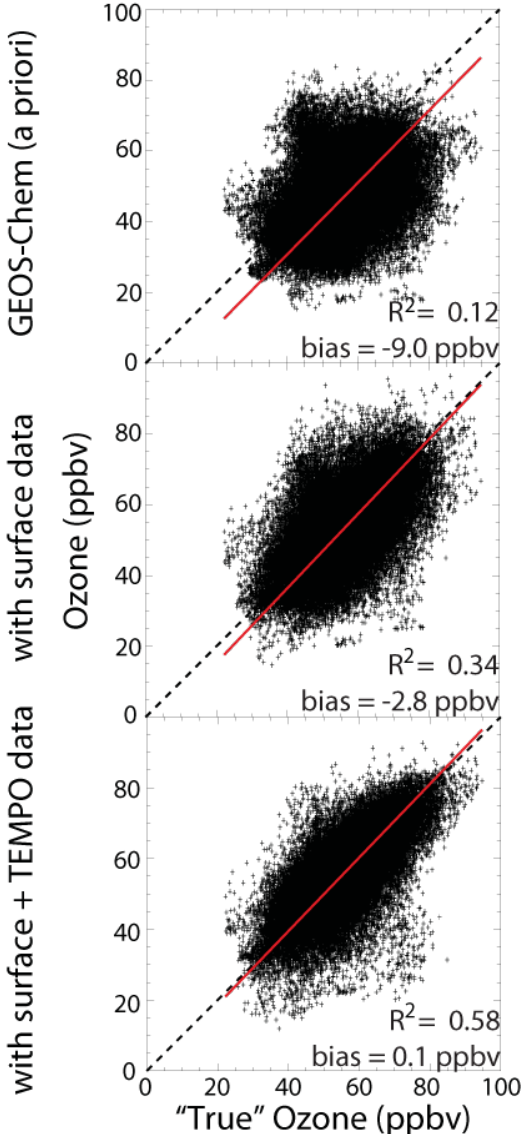
Figure 4. Improved monitoring of surface ozone across the In- termountain West from assimilation of synthetic CASTNet (sur- face) and TEMPO (geostationary satellite) observations. The figure shows scatterplots of simulated (GEOS-Chem) vs. “truth” (GFDL AM3) daily maximum 8h (MDA8) surface ozone for April–June 2010 for all 1/2 ◦ × 2/3 ◦ grid squares in the region (Fig. 1) and for individual days. Results are for GEOS-Chem without data assim- ilation (top), with assimilation of CASTnet synthetic surface data (middle), and with additional assimilation of TEMPO and LEO syn- thetic satellite data (bottom). Comparison statistics are inset. Also shown are the reduced-major-axis (RMA) regression line and the 1:1 line.